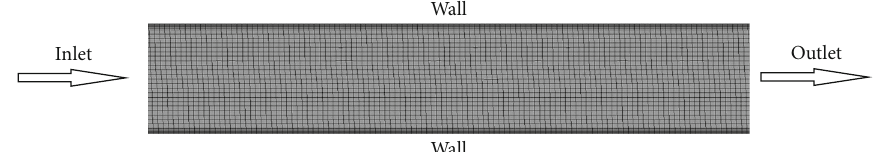
Figure 1: Schematic of grid.